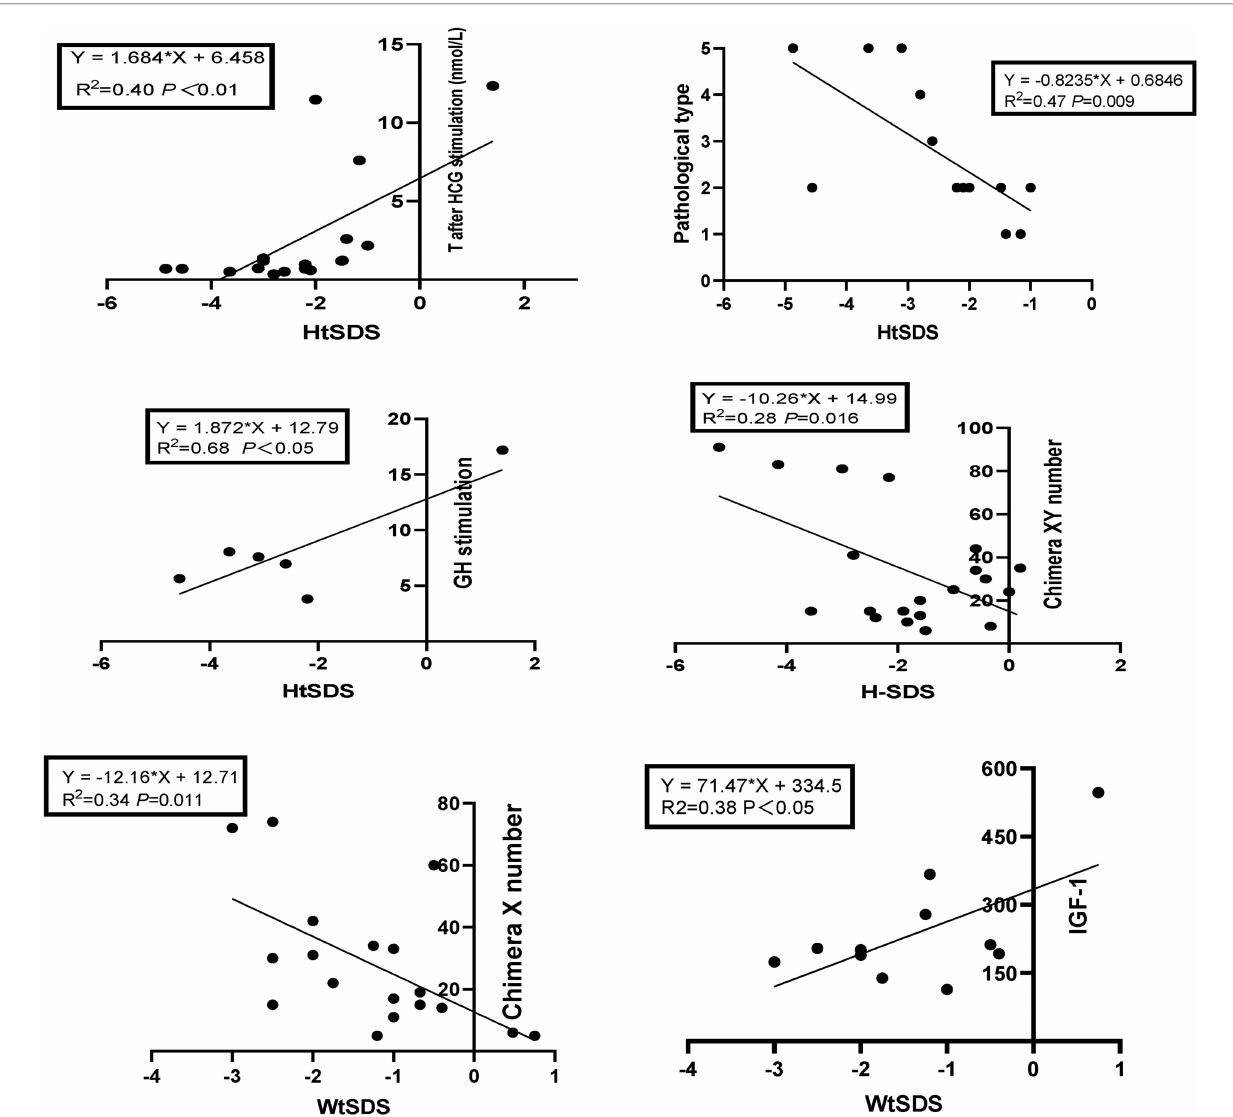
FIGURE 4 Regression equation of height SDS, weight SDS and related in fl uencing factors in 45,X/46,XY patients.